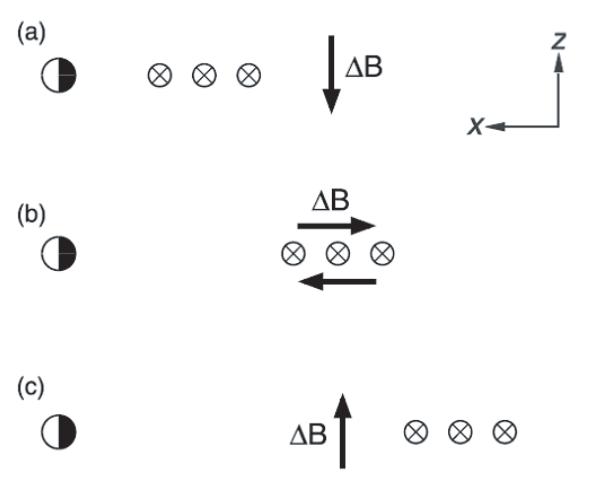
Fig. 16. Schematic representation of the relationship between B x and B z in terms of the tailward expansion of the current disruption region. (From Ohtani and Raeder,